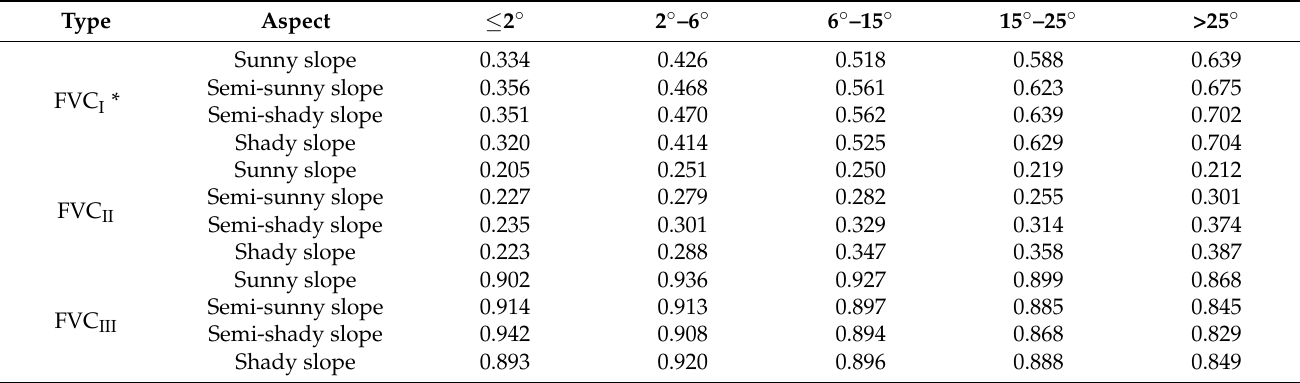
Table 3. Variation of FVC with different slope and aspect.